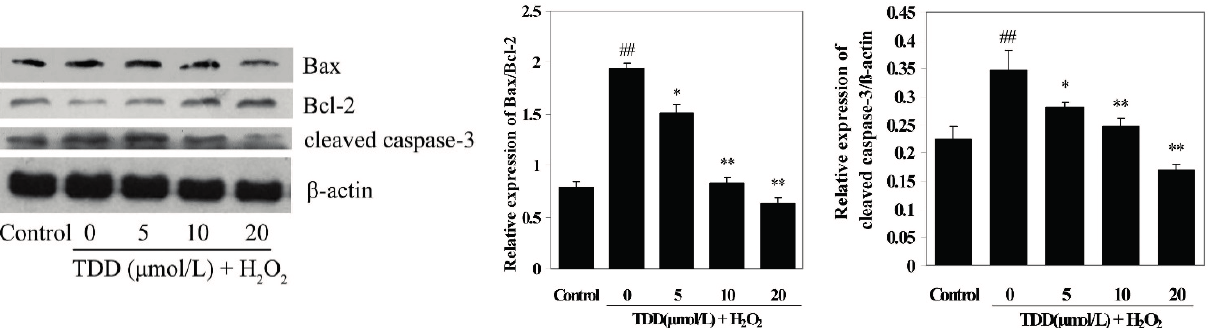
Figure 6. Effects of 2,4 ′ ,5 ′ -trihydroxyl-5,2 ′ -dibromo diphenylmethanone on the expression of Bcl-2, Bax and cleaved caspase-3 in H 2 O 2 -induced EA.hy926 cells by Western blot. Data are presented as mean ± SD ( n = 3). ** p < 0.01 vs. control; * p < 0.05 and ## p < 0.01 vs. H 2 O 2